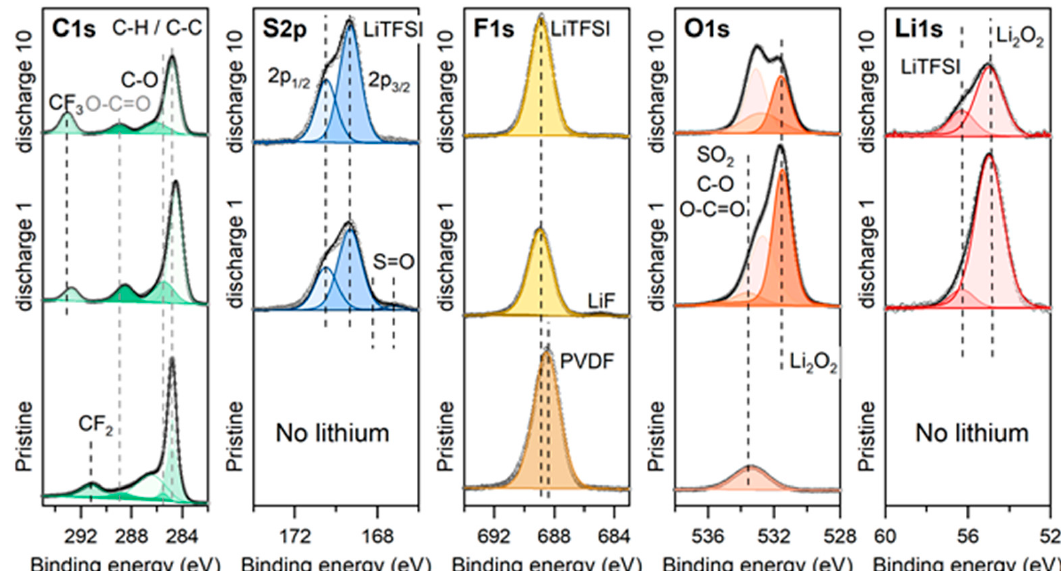
Figure 10. Ex situ XPS spectra of pristine and discharged MIL-53 electrodes in C 1s; S 2p, F 1s, O 1s and Li 1s regions.